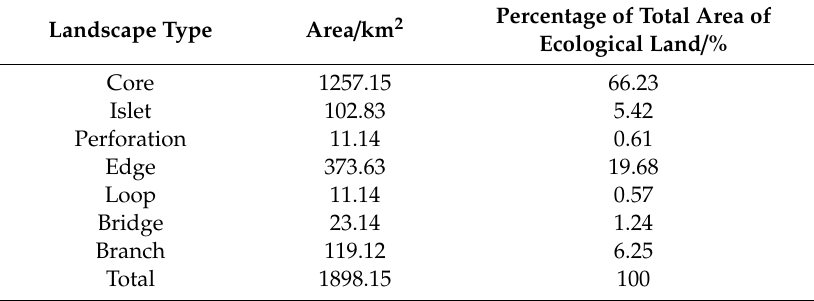
Table 4. Statistics table of MSPA.